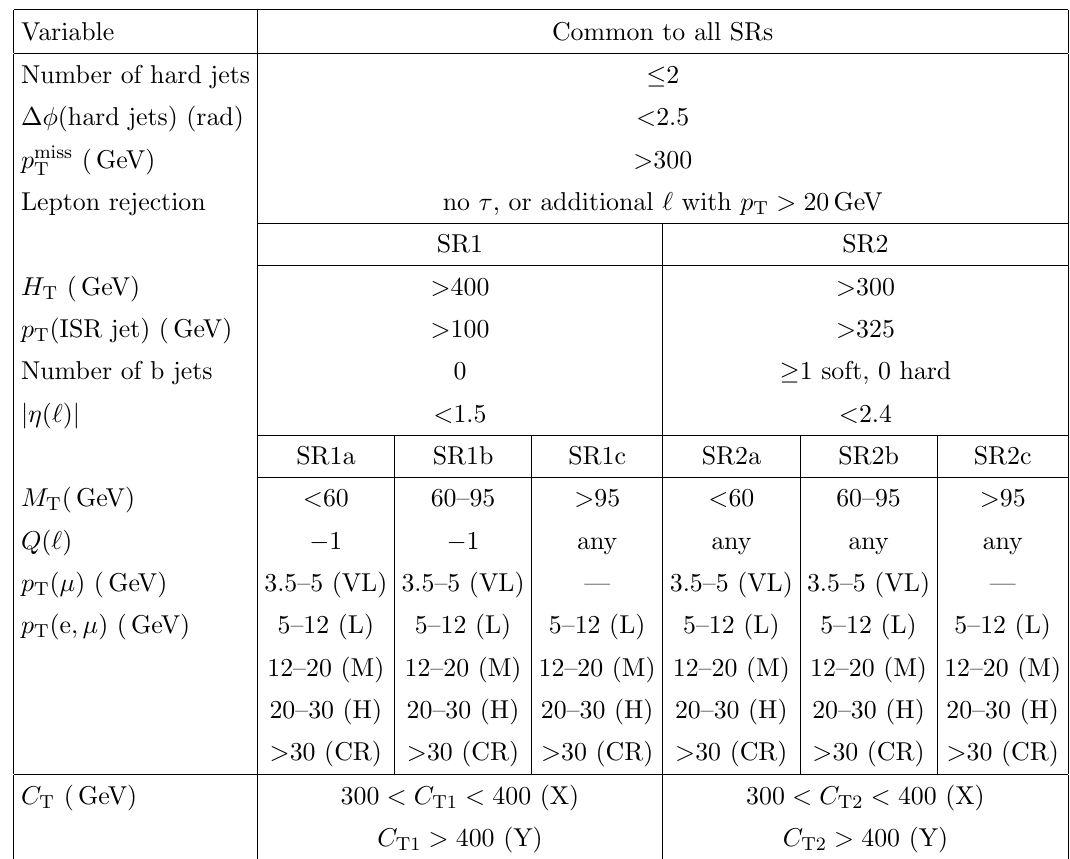
Table 1 . The CC search: de(cid:12)nition of SRs. The subregions of SRs are denoted by tags in parentheses, as described in the text: VL, L, M, and H refer to the four bins in lepton p T , and X and Y to the C T ranges speci(cid:12)ed in the table. The corresponding control regions (CR) use the same selection with the exception of the lepton p T as shown in the table. For jets, the attributes \soft" and \hard" refer to the p T ranges 30{60 GeV and > 60 GeV,